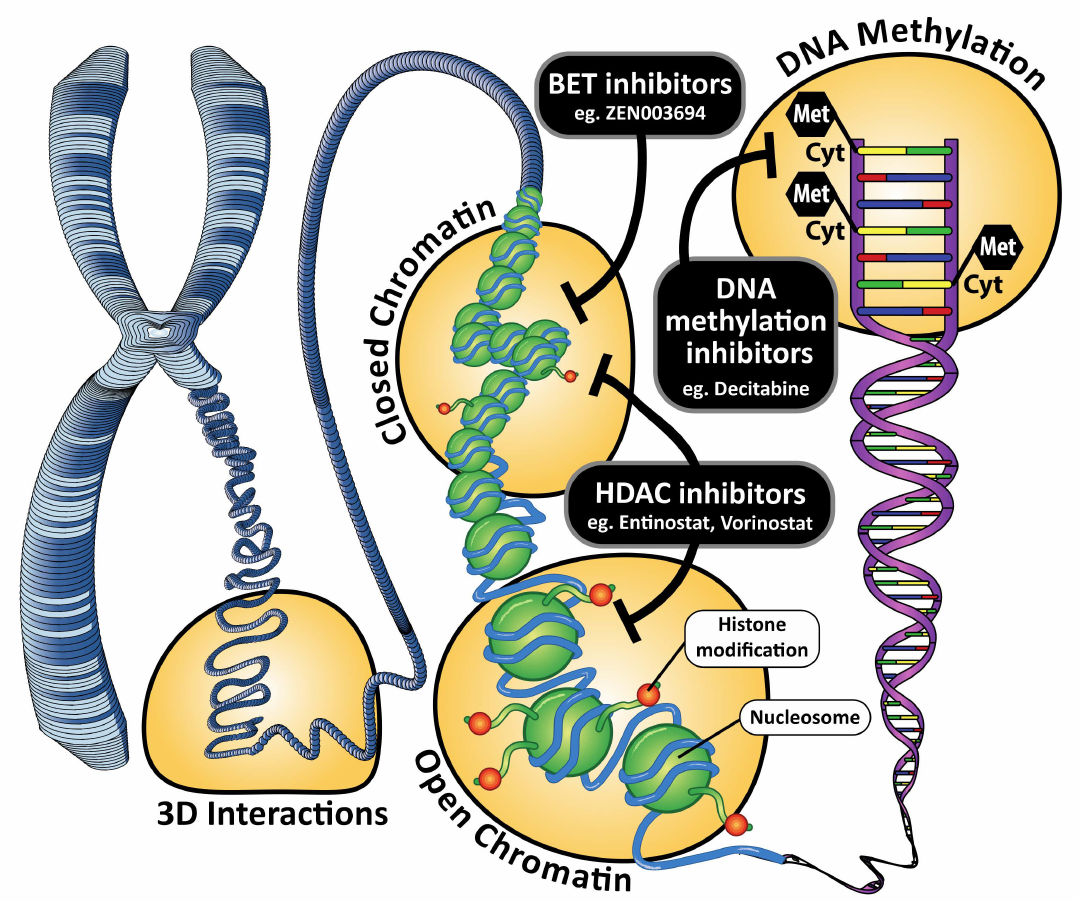
Figure 1. Sites of action of epigenetic therapies in breast